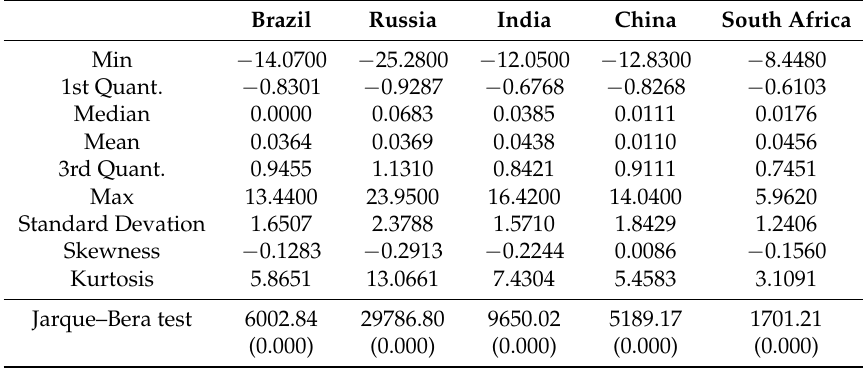
Table 1. Summary statistics. MSCI daily returns on BRICS countries from 19 July 1999 to 16 July 2015. p -values of the Jarque–Bera test are given in